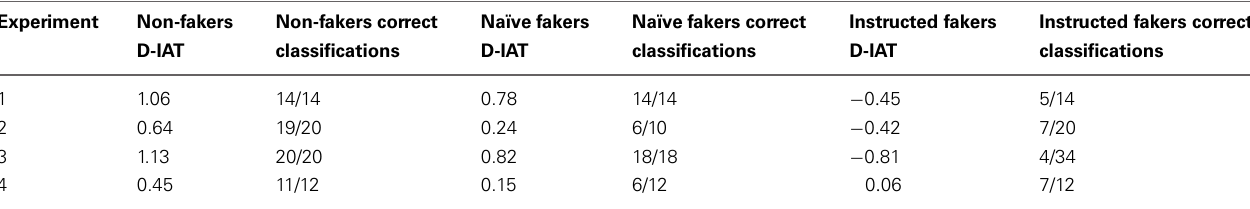
Table 4 | Data from four experiments comparing control non-fakers, naïve fakers, and instructed fakers are reported (Agosta et al., 2011b).